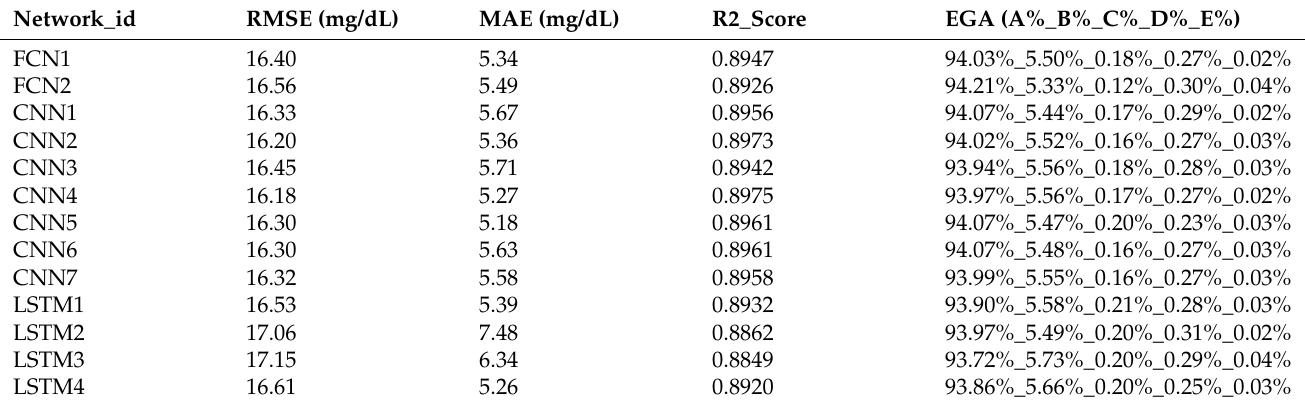
Table 4. The average prediction accuracy of 5-fold cross validation of 13 neural network